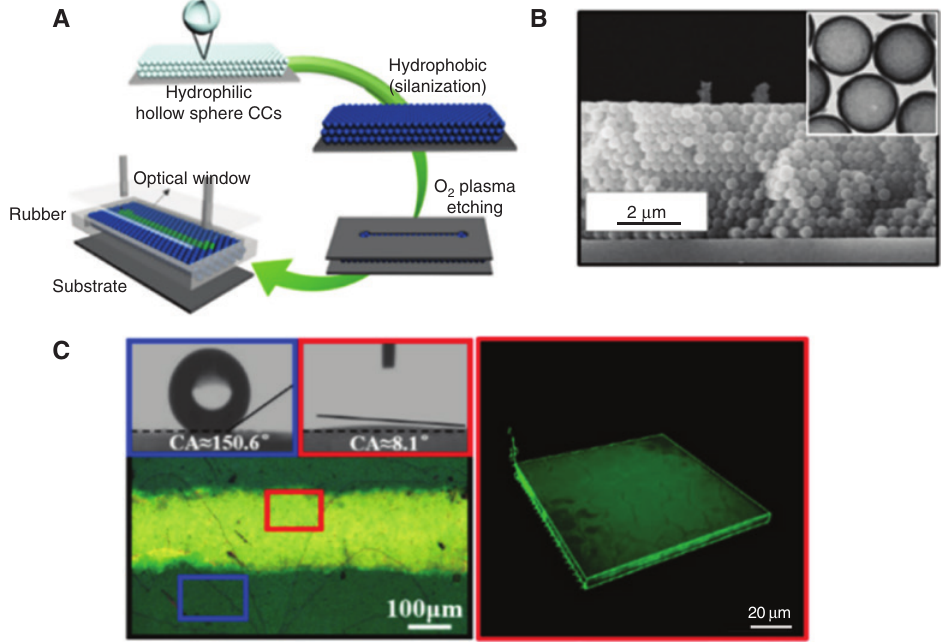
Figure 8: Fabrication of optomicrofluidics based on patterned HSCPCs. (A) Schematic illustration of the fabrication of process. (B) A cross-section SEM image of the obtained HSCPCs, inset is a TEM image of hollow spheres. (C) Left, microscope images show the introduced superhydrophilic channel (yellow region) in the superhydrophobic HSCPCs and the corresponding contact angle measured in or out the channel, in which the invisible channel was filled with water for visualization. Right, the two-photon fluorescence image of the hydrophilic region acting as microfluidic channel. Adapted with permission from ref. [33], COPYRIGHT 2016 The Royal Society of